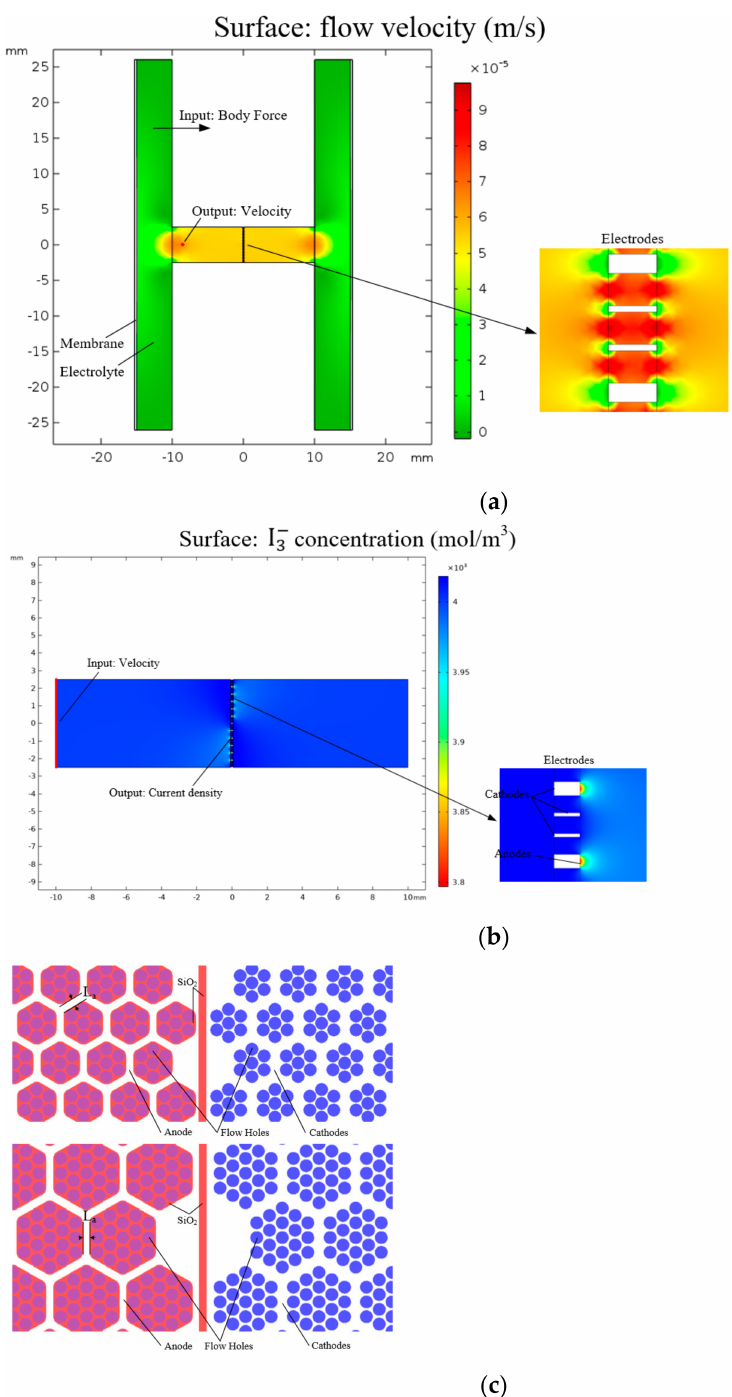
Figure 2. Simulation models: ( a ) Simulation model of the vibration link which took the volume force as the input and the liquid velocity at the midpoint of the channel edge as the output. ( b ) Simulation model of the electrochemical link which took the linear velocity of the end face of the channel as the input and the differential current of the two cathodes as the output. ( c ) Two arrangements of flow holes with the seven-hole structure on the top and the nineteen-hole structure at the